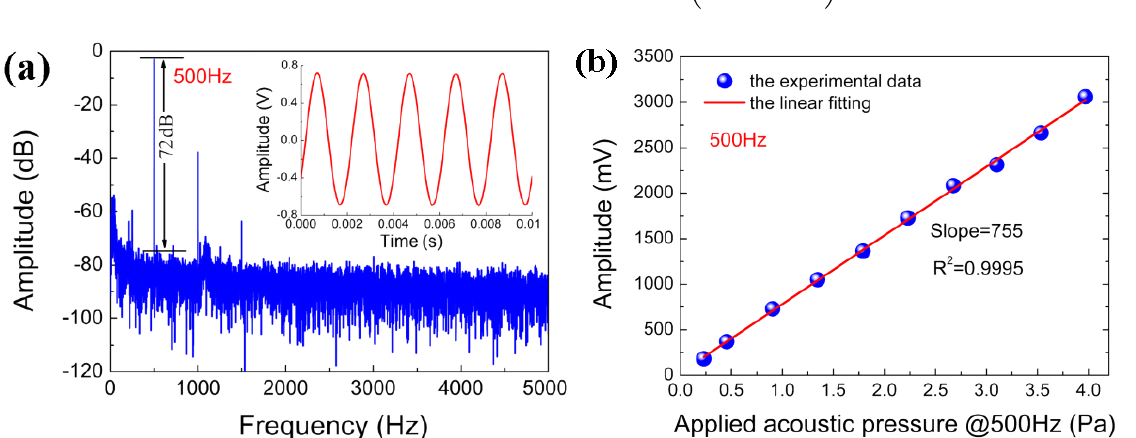
Figure 7. ( a ) time-domain response and frequency spectrum of the sensor to acoustic waves with Figure 7. ( a ) the microphone response in frquency domain to an airborne sound with a freqneucy of 500 Hz and 1 Pa; ( b ) the response amplitude versus applied acoustic pressure at 500 Hz. 500 Hz and a pressure of 1 Pa (inset: time domian response curve measured with the microphone); ( b ) the response amplitude versus applied acoustic pressure at 500